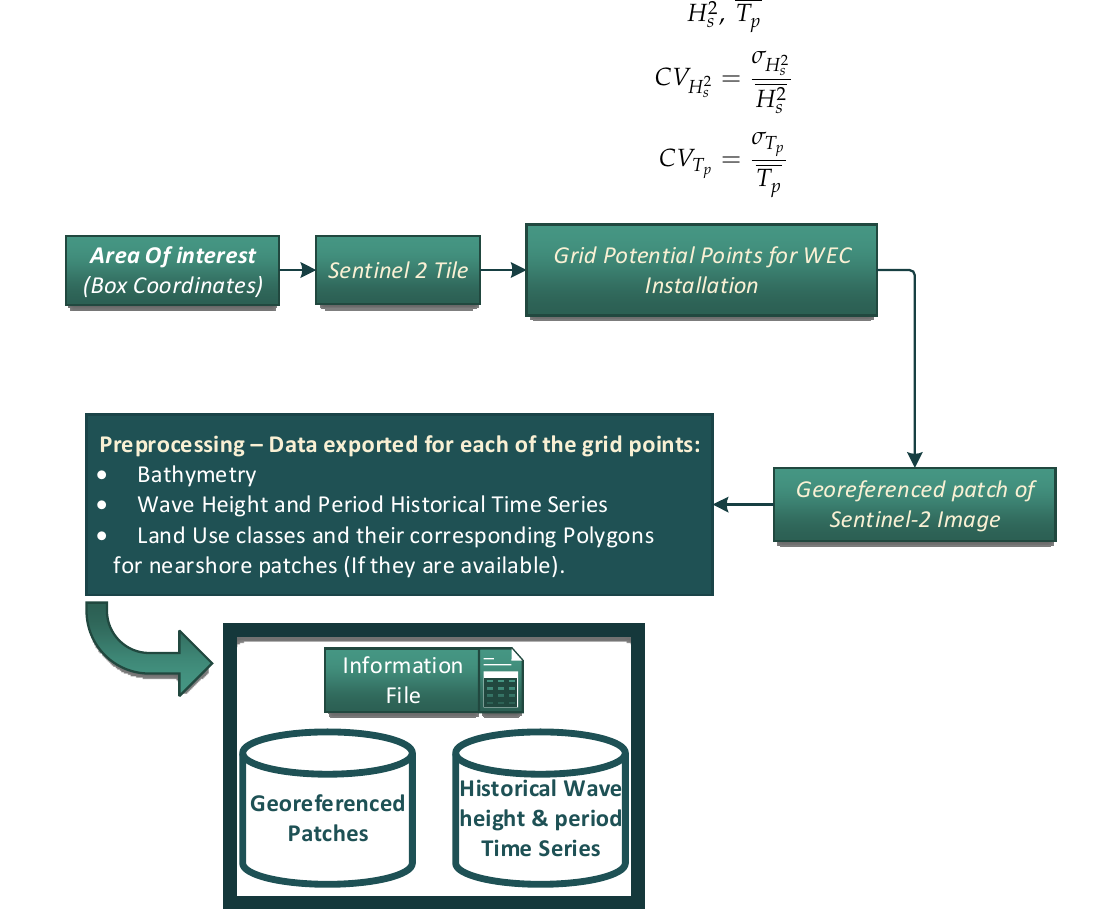
Figure 1. Flowchart of Geographic Information Tool.